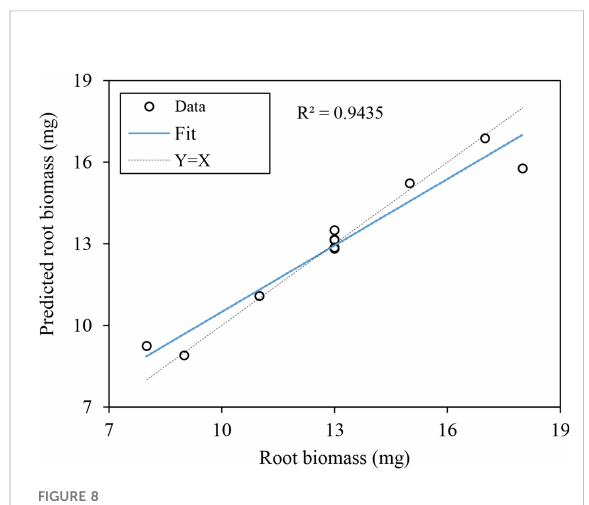
FIGURE 8 Relationship between values of root biomass as measured and predicted by the ANN model.